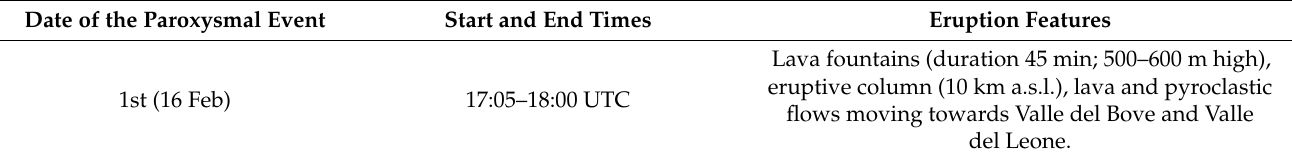
Table A1. Summary of the Mt. Etna paroxysms of 16 February–1 April